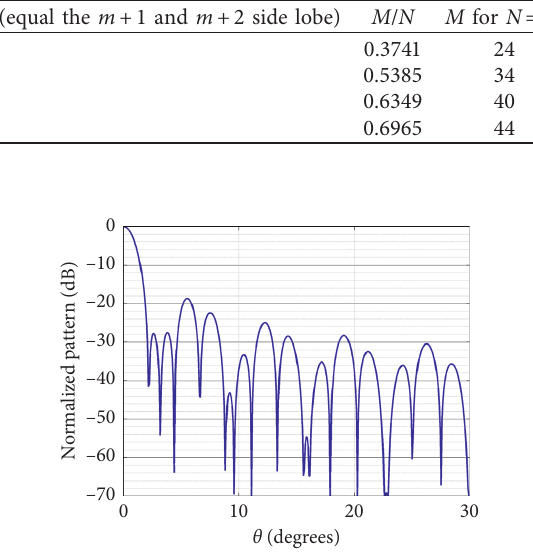
Figure 2: The array factor for N � 70, and M � 34. The 1 st and 2 nd SLLs are approximately equal.